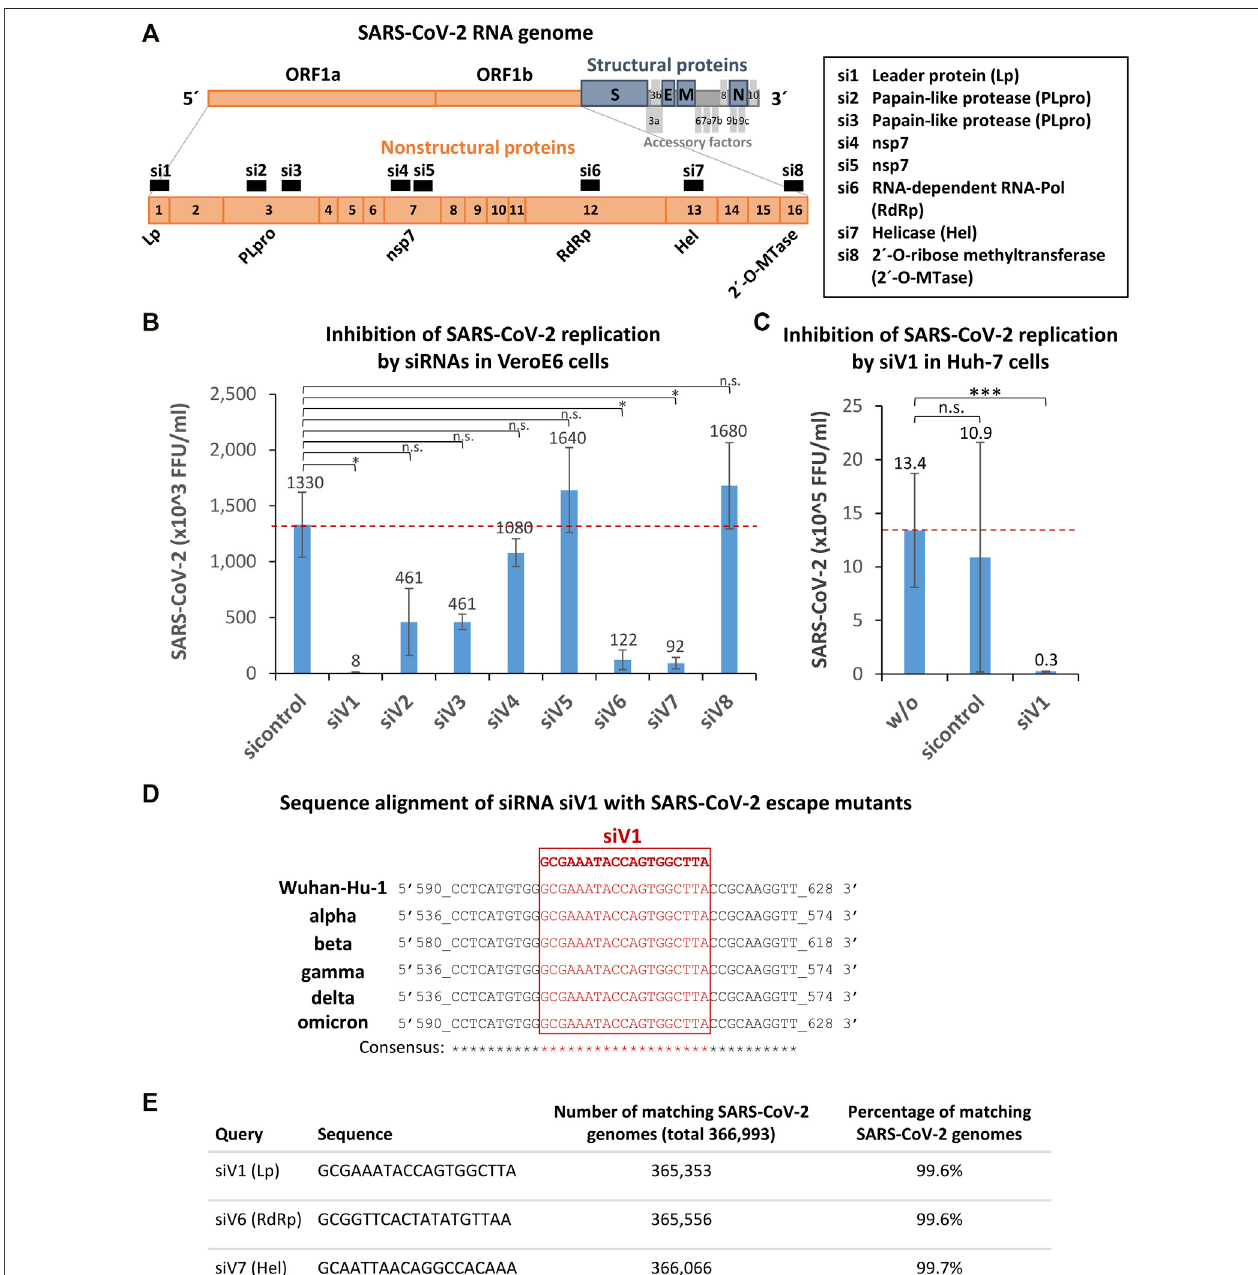
FIGURE 2 | Identi fi cation, selection, and validation of SARS-CoV-2 Orf1a/b speci fi c siRNAs capable of inhibiting SARS-CoV-2 replication within the host cells. (A) Selection of siRNA target and schematic representation of the SARS-CoV-2 RNA genome. Eight siRNAs (siV1-8) derived from non-structural viral proteins (nsp) encodingopenreadingframe1a/b(Orf1a/b) weredesignedbyalgorithms. OrangeboxesdenotenspencodingORF1aand 1b;blue boxesthestructuralproteins: spike (S), envelope (E), membrane (M), and nucleocapsid (N). Grey boxes symbolize the accessory factors. Orange boxes, black numbered with 1 – 16 mark the nsp coding regions. siRNAs are indicated as black numbered boxes (si1-8) and the corresponding siRNA targeting regions are labeled as followed: Leader protein (Lp), Papain-like protease (PLpro), Papain-like protease (PLpro) (2x), nsp7 (2x), RNA-dependent RNA-Pol, helicase (Hel), and 2 ′ -O-ribose methyltransferase (2 ′ -O-Mtase). The graphic was adapted from (Romano et al., 2020). (B) Identi fi cation of siV1 as the most effective siRNA that strongly inhibits SARS-CoV-2 replication. Vero E6 cells were transfected with siV1 - siV8 or control-siRNA 24 h prior to cell infection with SARS-CoV-2 (100 foci forming units). After 1 h, the supernatants were replaced with overlay medium containing 1%methylcellulose. 24 h later, cells were fi xed, permeabilized and immunohistochemically stained, using an anti-SARS-CoV-2 spike protein antibody.Viralspotswereautomaticallydetectedbyimmunespotanalyzerandquanti fi edasfocusformingunits(FFU).Datarepresentthemean±s.d.ofn=2biological replicates determined in n = 4 technical replicates. Signi fi cance: not signi fi cant (n.s.), p ≤ 0.05 (*); two-sided unpaired-t test. (C) Validation of siV1-mediated inhibition of SARS-CoV-2 replication in human Huh-7 cells. Huh-7 cells were transfected with siV1 or control-siRNA. After 5h, cells were infected with SARS-CoV-2. Cell culture supernatants were harvested after 72 h and viral RNAs were isolated and quanti fi ed by RT-qPCR. Non-transfected cells were used as a control. Data represent the